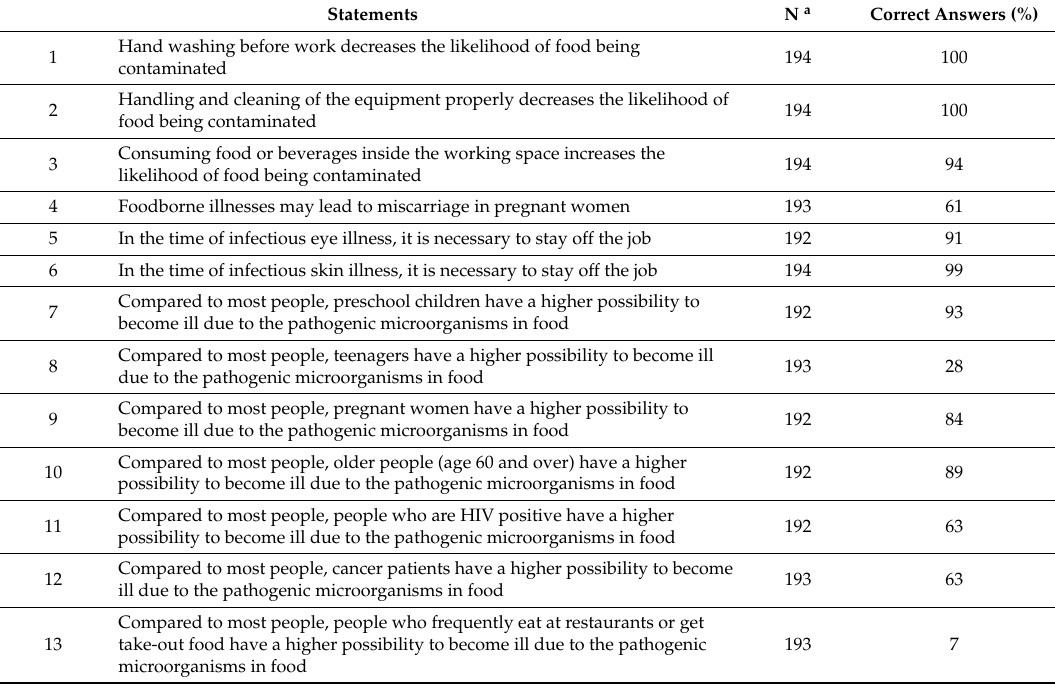
Table 2. Food safety related knowledge among dairy plant